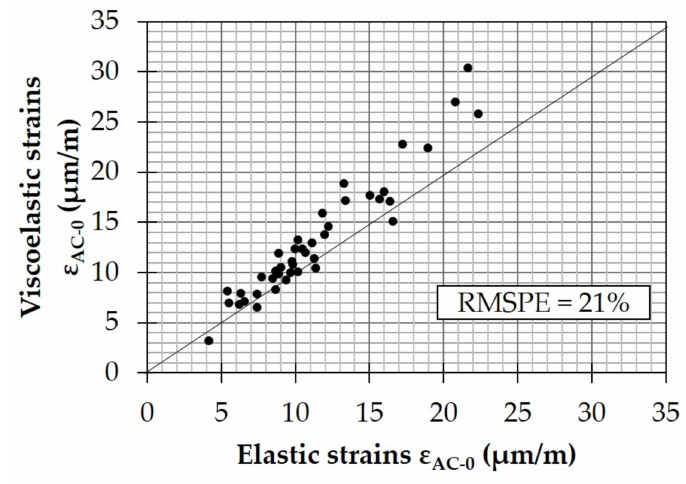
Figure 13. Comparison of horizontal strains at the pavement’s surface (zero